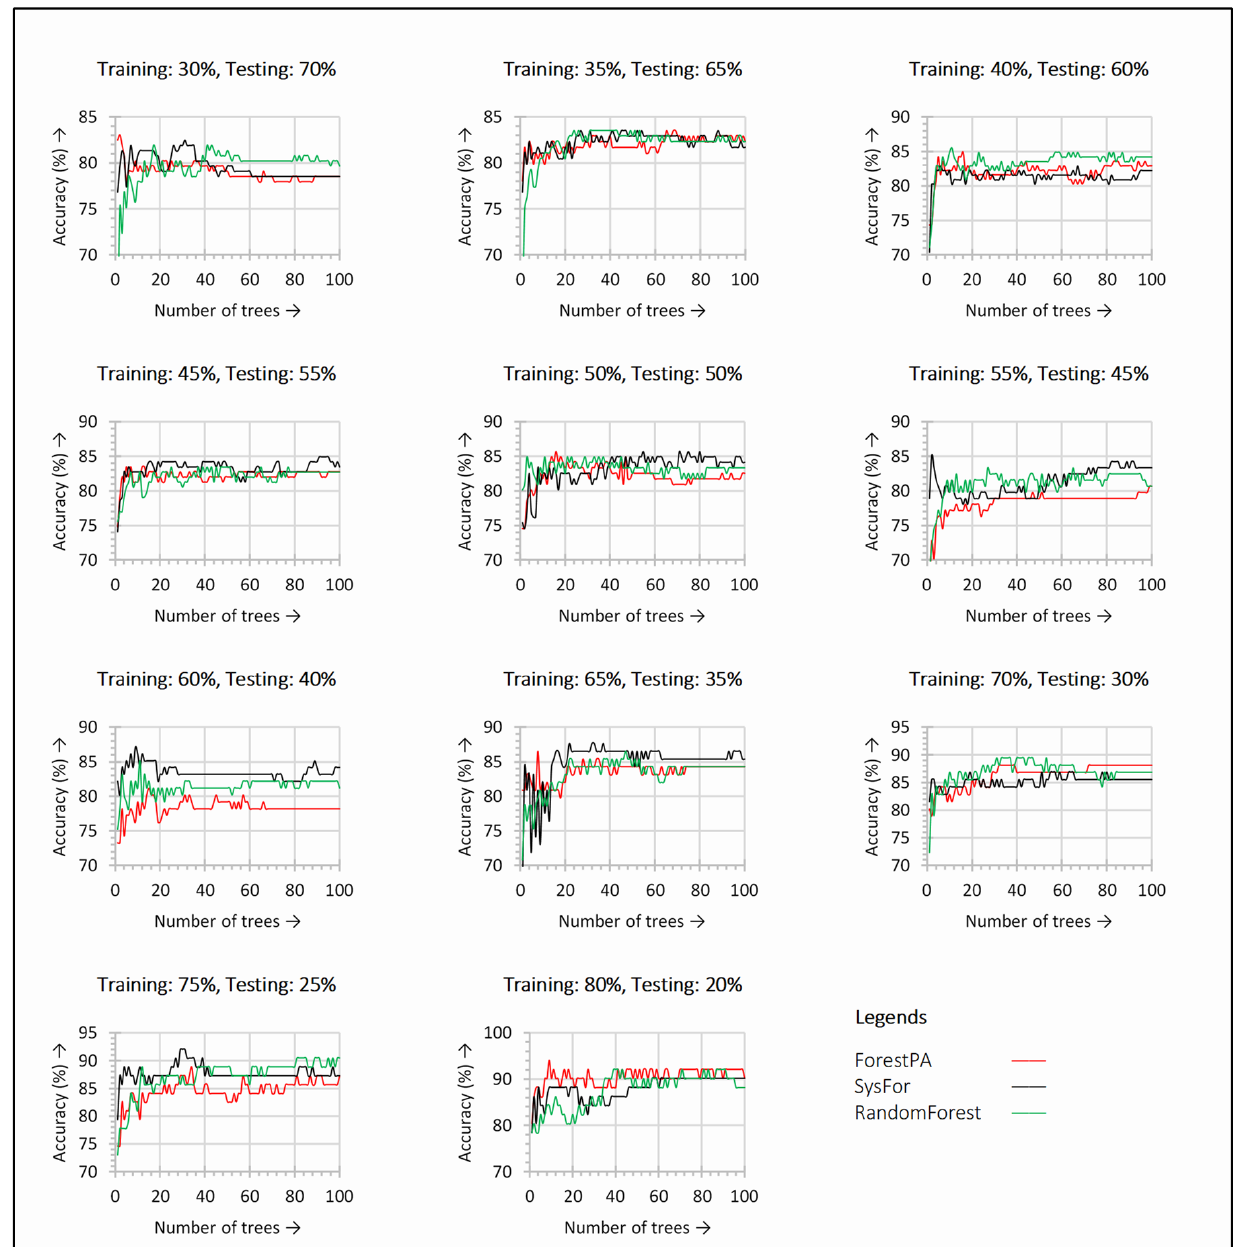
Figure 2. Detection accuracy with respect to change in number of trees in the decision forests observed for each training and testing split on Istanbul acoustic